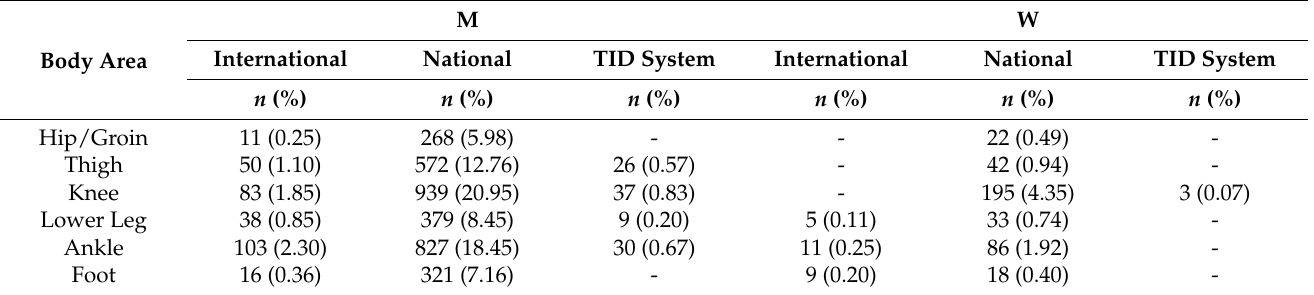
Table 3. Injury prevalence (body area) of the lower limb in handball players based on sex and competitive level. Body Area